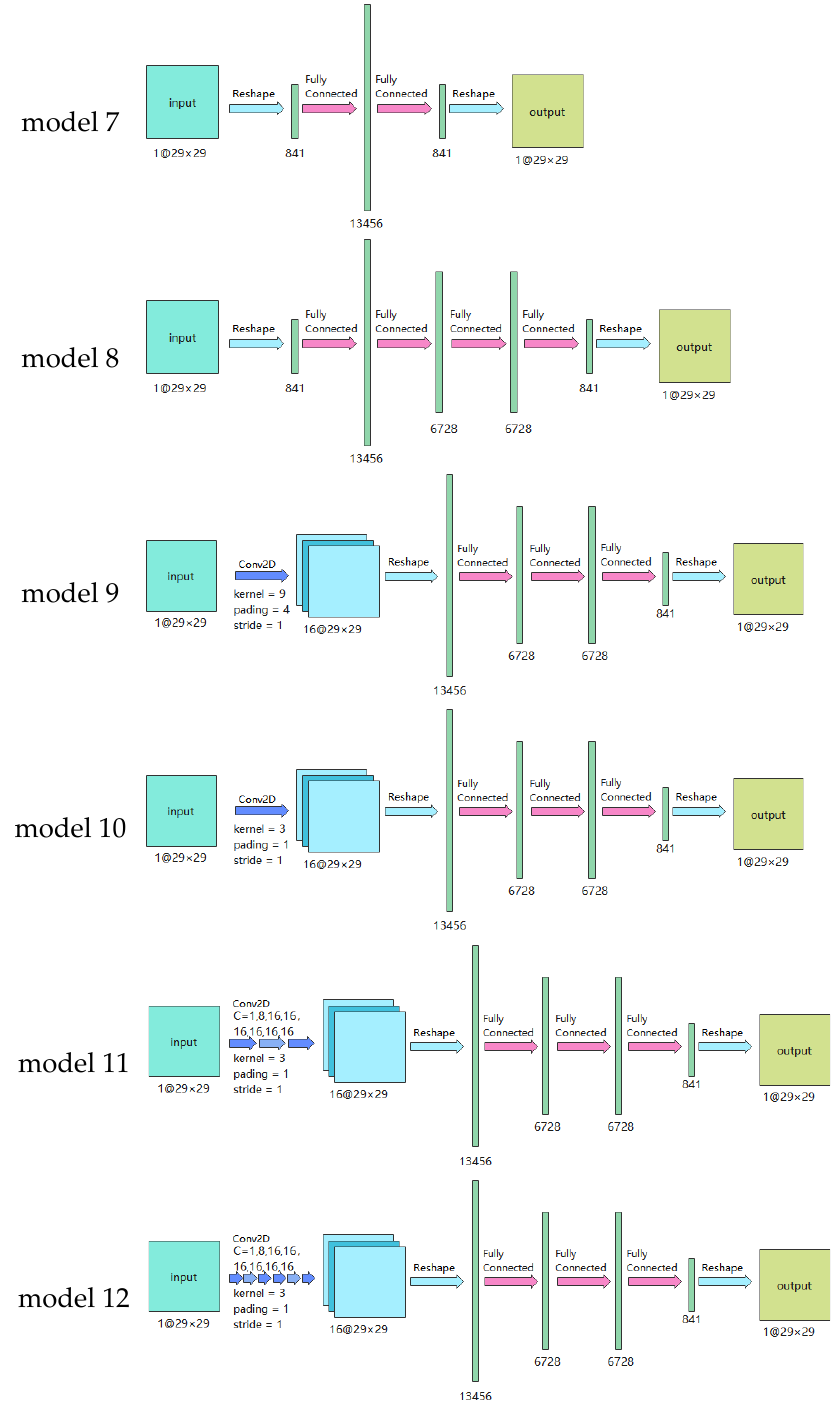
Figure 9. Diagram of each neural network model structure in Group B. Table 4. Architecture of models in Group A.